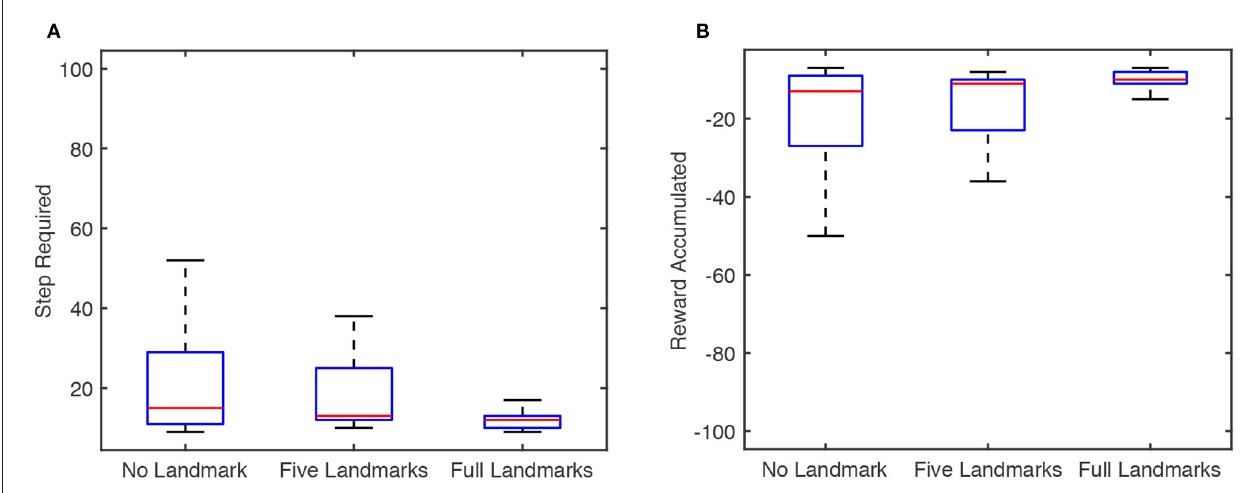
FIGURE 7 | Box plot of results for the articulated agent in the proposed articulated goal-oriented learning model reaching a goal position [surface = 3, x = 1, y = 2] on a 2 2 2 cube over 30 tests, in which the random seeds are different. The figure is based on the result at the end of each test. The blue box represents the × × interquartile range (IQR) between the 25 % quantile (Q1) and 75 % quantile (Q3). The bottom and top edges of the box indicate the Q1 and Q3, respectively. The red horizontal line in the blue box represents the median. The minimum and maximal value in the [ Q 1 black horizontal lines, respectively. (A) Step required for the agent to reach the goal on the cube with different numbers of tactile landmarks. (B) Reward accumulated for the agent on the cube with different numbers of tactile